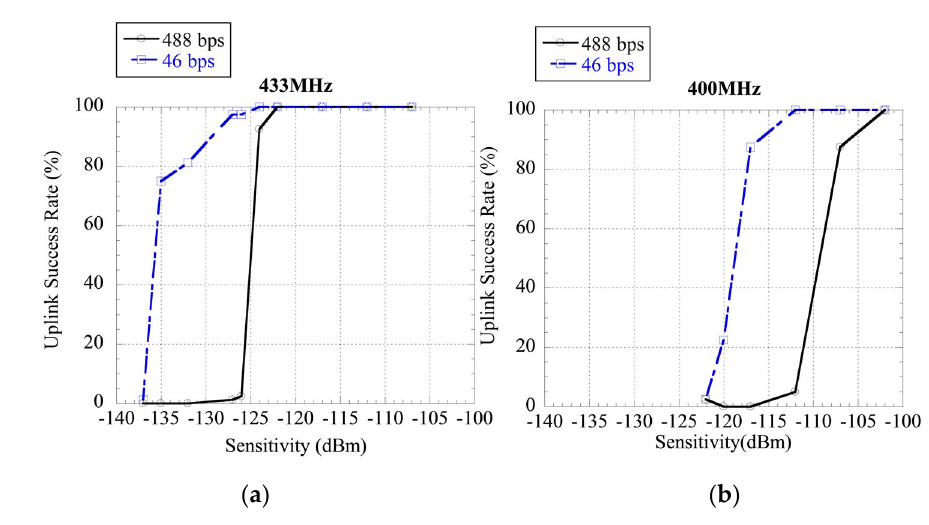
Figure 12. Uplink success rate for receiver sensitivity of ( a ) 400 MHz and ( b ) 433 MHz.